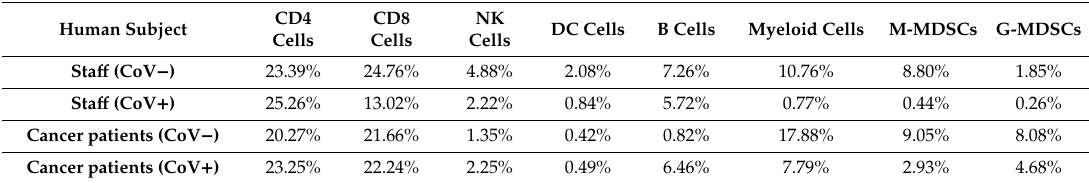
Table 3. The relative changes in the percentage of immune cells in di ff erent human subjects positive or negative to SARS-CoV-2 IgG. CyTOF analysis was performed on peripheral blood cells from sta ff and cancer patients either negative to SARS-CoV-2 IgG (CoV − ) or positive to it (CoV + ). The percentages in the table are after samples were